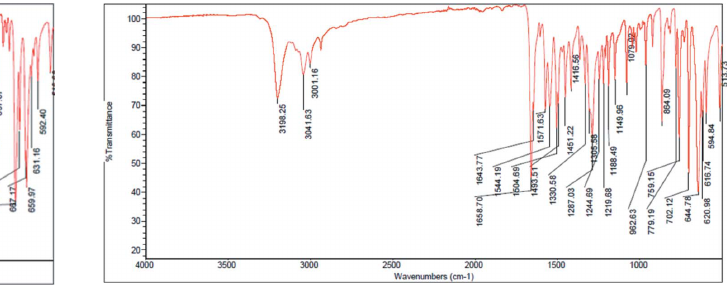
Figure 7 IR spectrum of the AmCl salt.